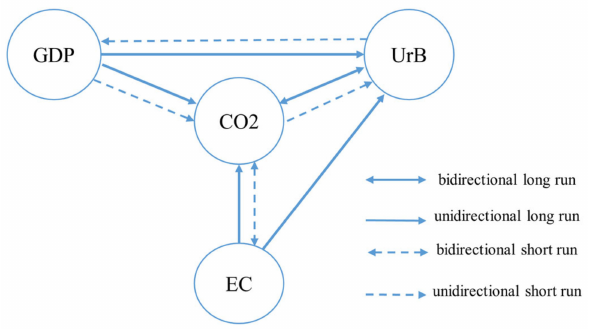
Figure 5. Pairwise Granger causality